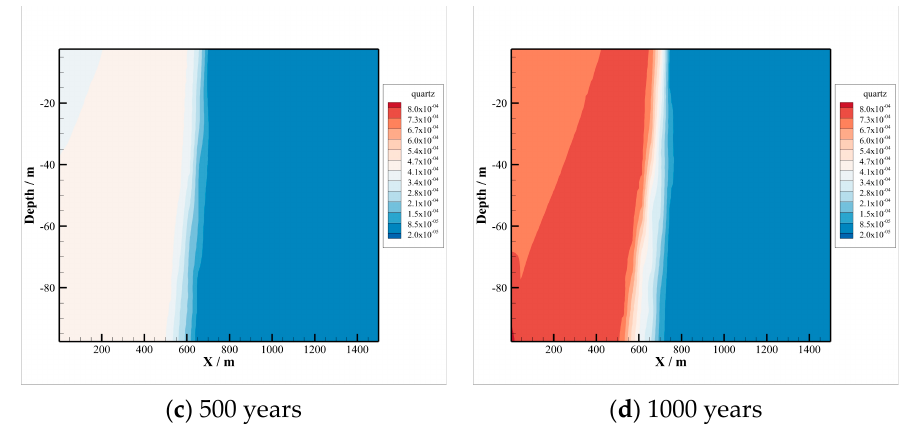
Figure 7. Quartz after CO 2 injection.